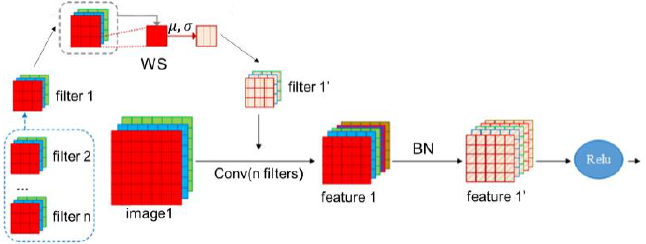
Figure 5. Process of weight standardization.